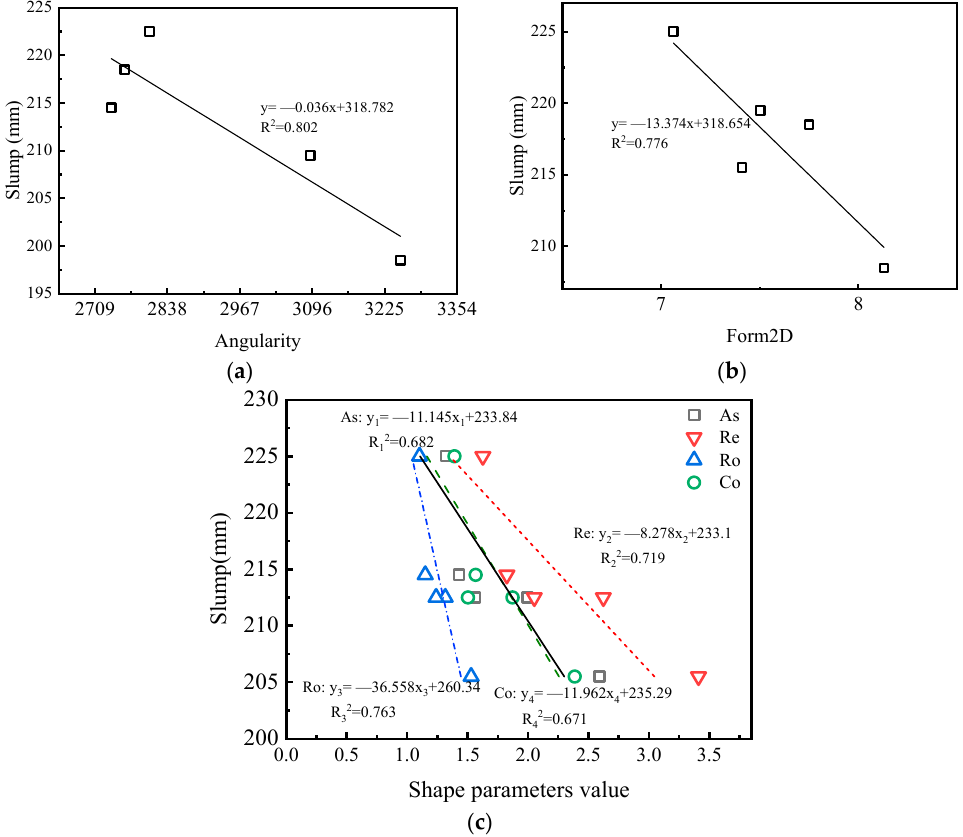
Figure 17. Correlations between particle shape parameters and slumps of concrete: ( a ) angularity, ( b ) form2D, ( c ) and DIP shape parameters. ( b ) form2D, ( c ) and DIP shape parameters.